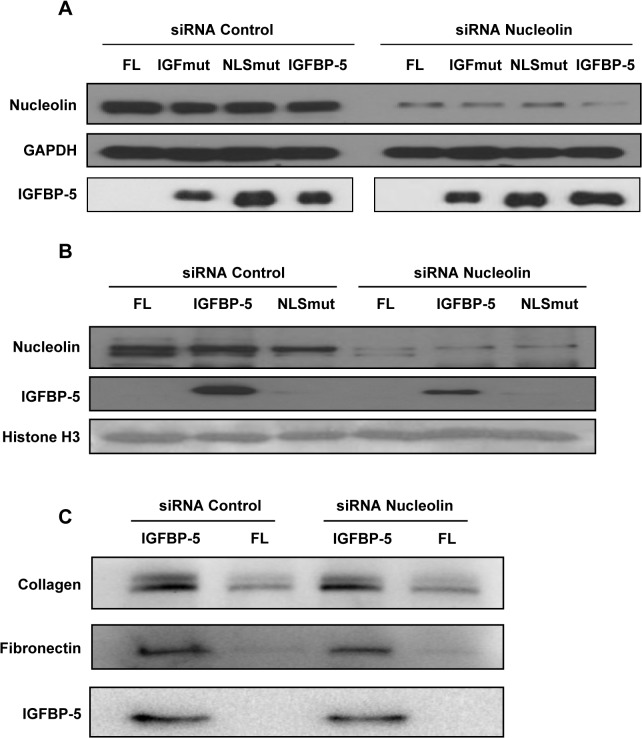
Silencing nucleolin does not alter the ECM-promoting effects of IGFBP-5.(A) Nucleolin is efficiently silenced using sequence-specific siRNA. Silencing nucleolin has no effect on IGFBP-5 production. (B) Silencing nucleolin inhibits translocation of IGFBP-5 to the nucleus as detected by immunoblotting of nuclear extracts. Histone H3 is used to confirm nuclear localization. (C) Silencing nucleolin does not alter the ECM-promoting effects of IGFBP-5 as detected using immunoblotting.